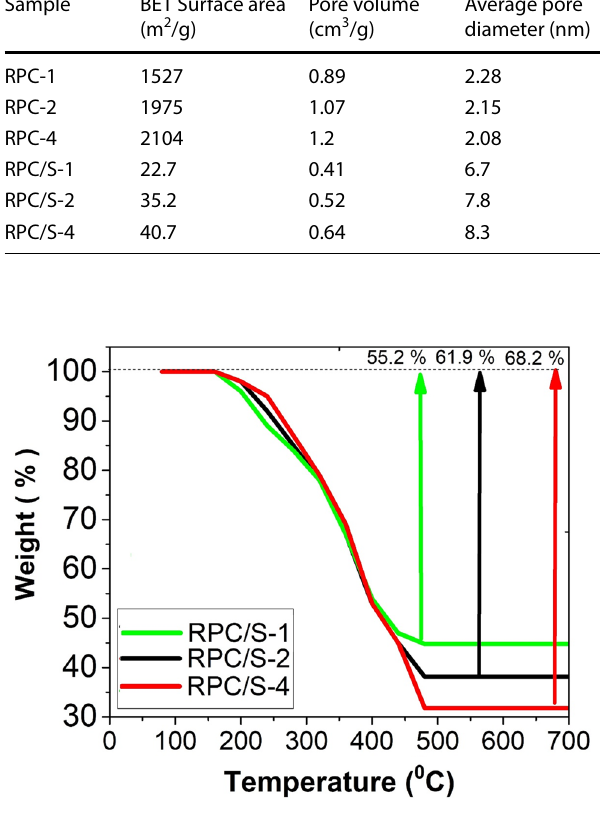
Fig. 4 TGA curves of sulfur composites of rambutan peel based porous carbons obtained at 900 °C with different impregnation